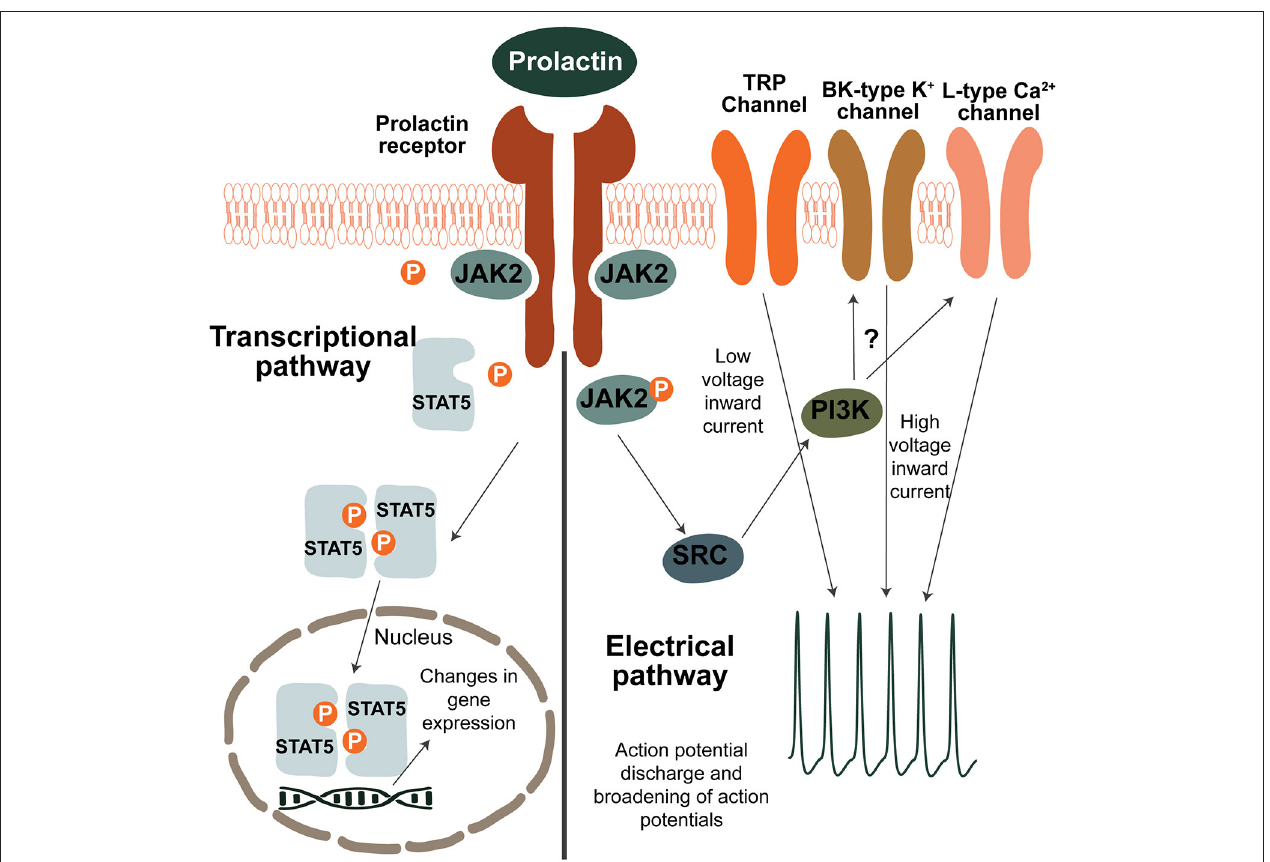
FIGURE 1 | Prolactin-induced signaling pathways in neurons. Transcriptional pathway: binding of prolactin to the prolactin receptor (Prlr) results in activation of JAK2 which in turn phosphorylates several tyroside residues on the Prlr. This causes binding and phosphorylation of STAT5 which then dissociates from the receptor. Two pSTAT5 molecules dimerise and translocate to the nucleus where they lead to changes in gene expression by binging to the promoters of target genes. To induce changes in electrical activity, prolactin activates a low voltage and a high voltage current. The low voltage component is dependent on TRP channels. The high voltage component requires BK-type K + and L-type Ca 2 + channels and is dependent on activation of PI3K, however the precise mechanism is unknown. It should be noted that although possible pathways of prolactin-induced signaling are illustrated here, prolactin preferentially acts through the different pathways in a cell-specific and reproductive-state specific